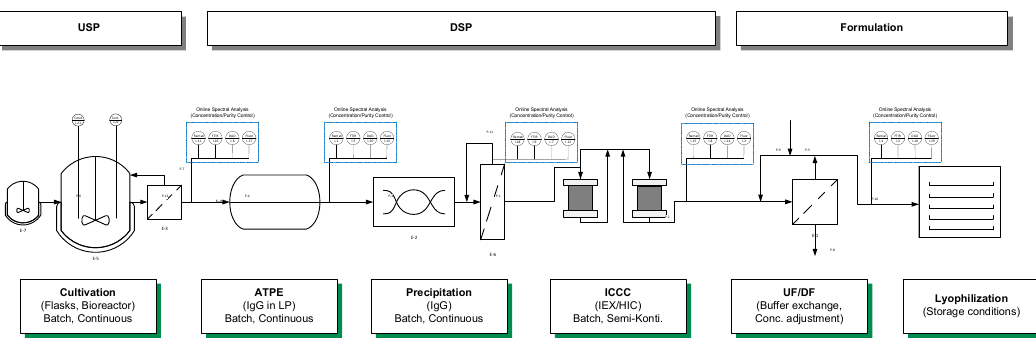
Figure 3. Proposed process flow sheet including spectroscopic PAT sensors. A PAT measurement array is placed at the outlet of each unit operation to provide real time data on monoclonal antibody (mAb), high molecular weight (HMW) impurities, and light molecular weight (LMW) impurity concentrations that are then used as input for the process model, which calculates the necessary process adjustments to ensure operation within a pre-defined design space.